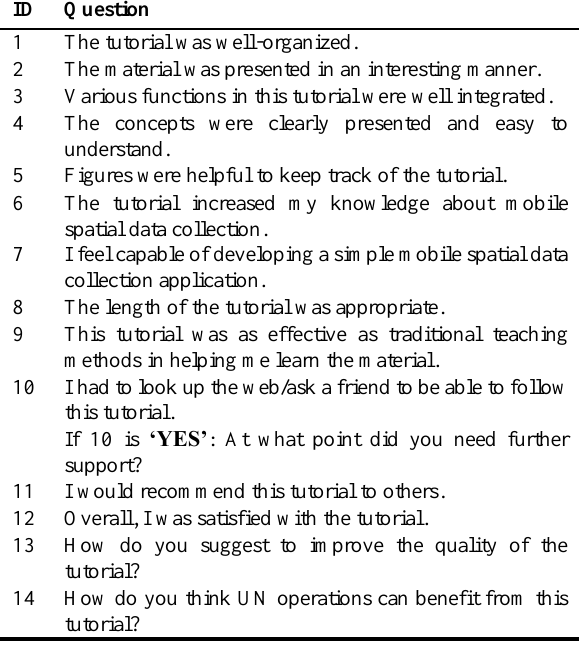
Table 2. Educational material usability questionnaire